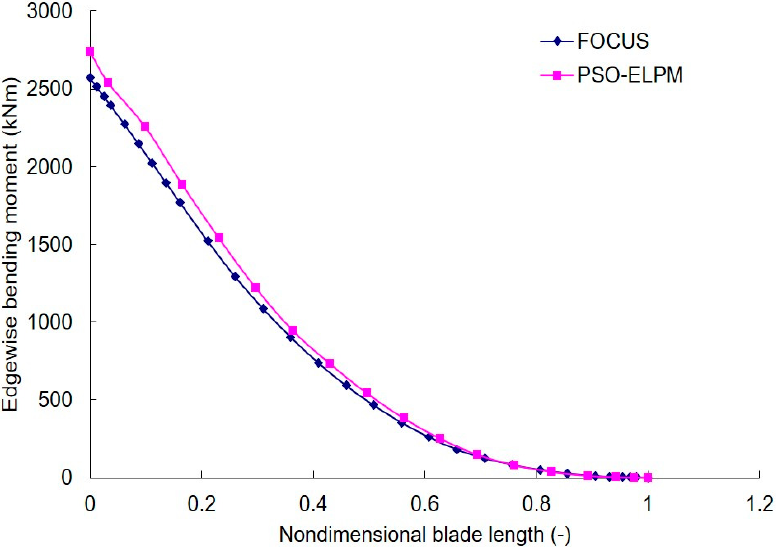
Figure 11. Comparison of extreme edgewise bending moment along the blade (1.5 MW).